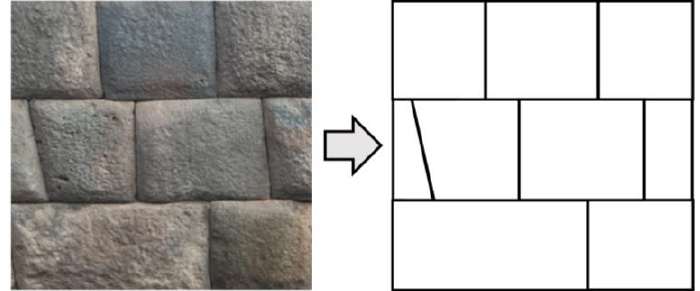
Figure 1. Illustration of dry-joint wall construction and its DEM representation.